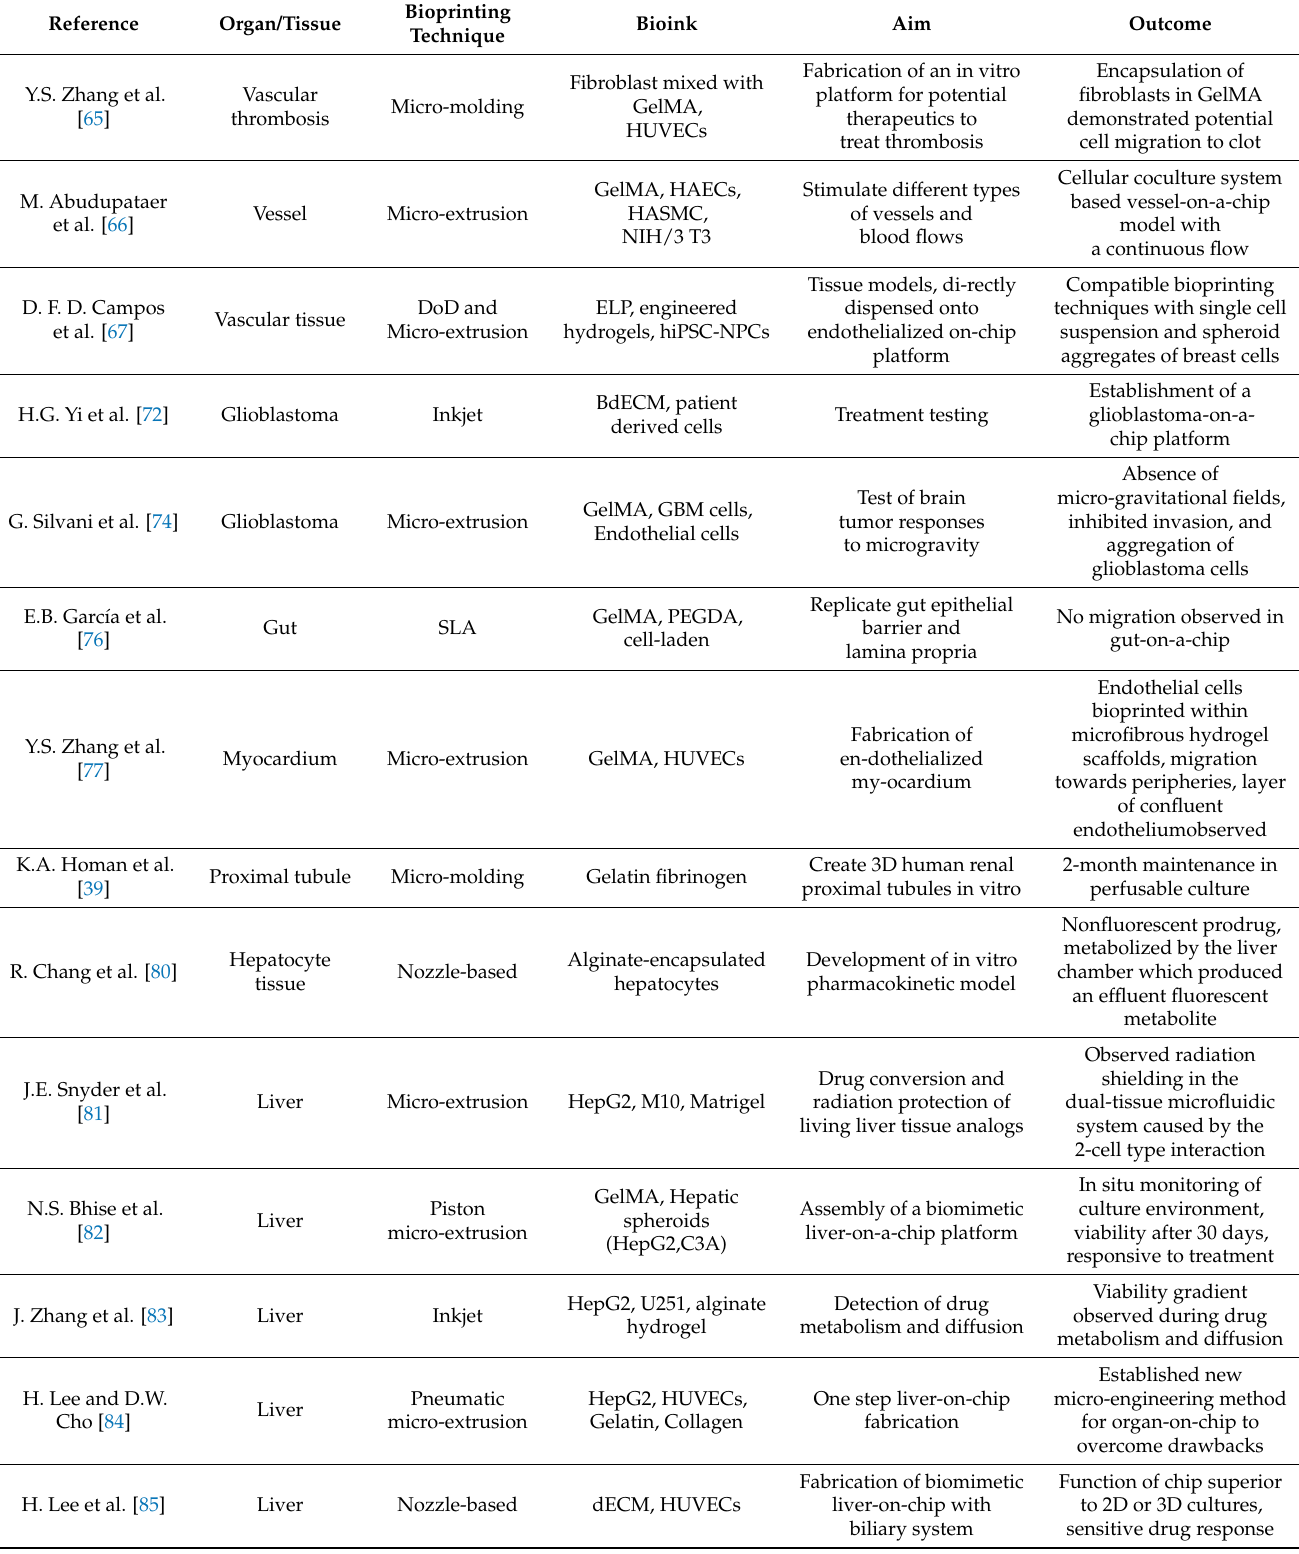
Table 1. Summarized applications of 3D bioprinting for developing organ-on-chip